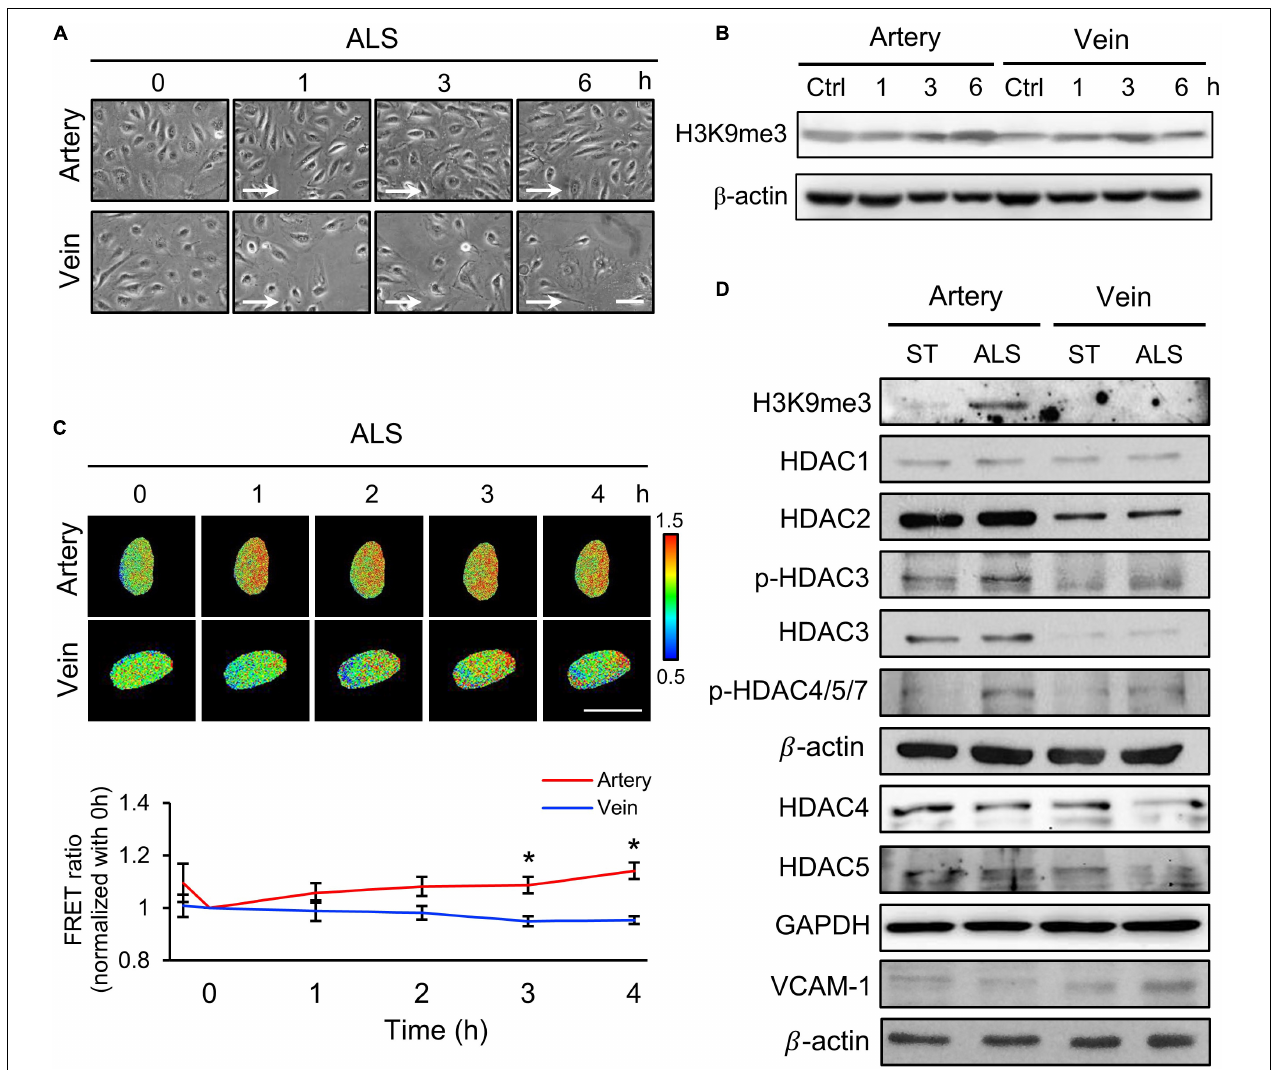
FIGURE 2 | The different effect of arterial and venous ECs under ALS. (A) Morphology observations of arterial ECs (HUVECs) and venous ECs (HSVECs) after being subjected to ALS for 0, 1, 3, and 6 h. (B) The Western blot analysis for the expression of H3K9me3 and β -actin in total cell lysates from (A) . The expression of H3K9me3 was time-dependent increase in arterial ECs but not in vECs. (C) The time-lapse FRET ratio images of HUVECs and HSVECs expressing the H3K9me3 biosensors were recorded to track the status of H3K9me3 every 2 h under ALS for 12 h. Compared to HUVECs, no FRET ratio of activated H3K9me3 was observed in vECs upon ALS stimulation at different time points (0, 1, 3, and 6 h). (D) Protein expressions were examined by using Western blotting analysis. HUVECs and HSVECs were subjected to ST or ALS condition for 24 h. Lower expression of H3K9me3 in ALS-treated HSVECs compared to ALS-treated HUVECs was shown. ALS decreased the HDAC4 and HDAC5 and increased VCAM-1 in ALS-treated HSVECs. The increases of HDAC3, HDAC4, HDAC5, p-HDAC3, and p-HDAC4,5,7 were observed in ALS-treated HUVSCs at 24 h. Scale bar in (A) = 200 µ m. Arrow indicated the flow direction of ALS (left to right). Scale bar in (C) = 20 µ m. Data were represented as mean ± SEM. * p -values were calculated using one-way ANOVA with Tukey’s multiple comparisons post-tests. * p < 0.05 compared to the vECs